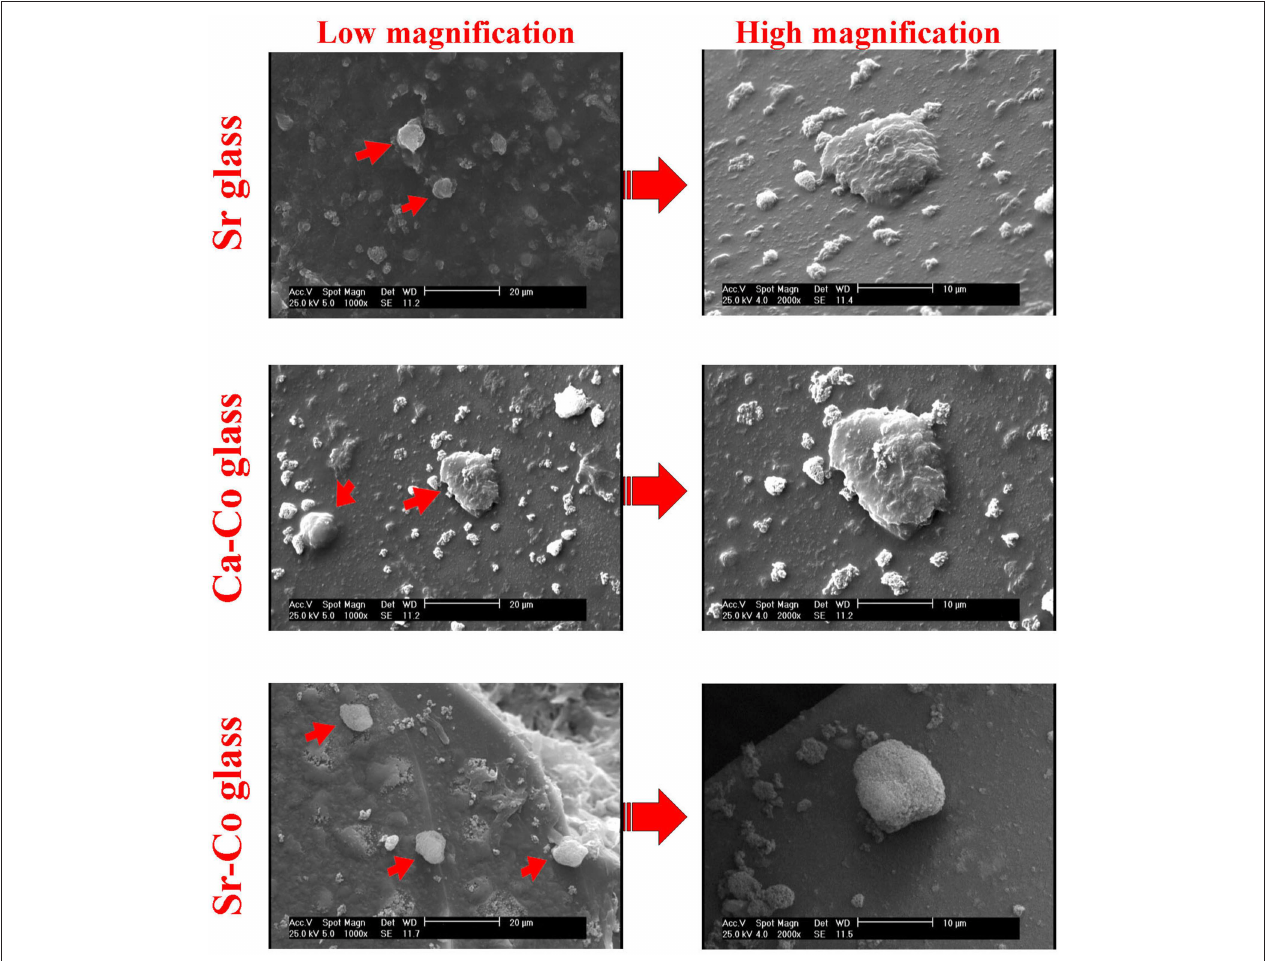
FIGURE 4 | The SEM images captured from the iPSCs onto the glass samples after 5 days post-seeding. As can be seen, the cells maintain their round morphology on the surface of the glass